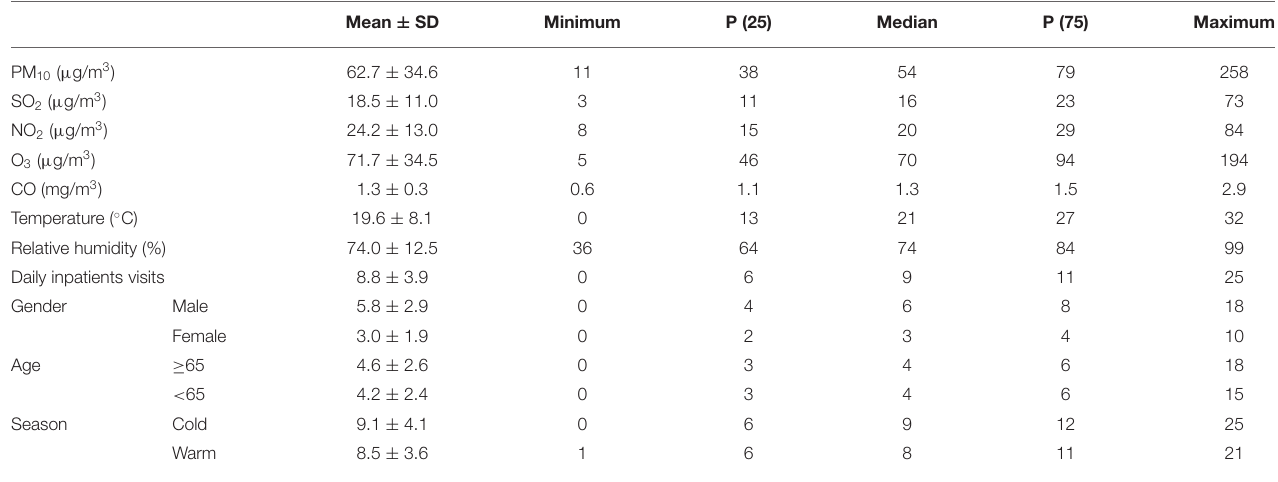
TABLE 1 | Data for ambient air pollutants, weather conditions, and respiratory inpatient visits in Ganzhou from 2017 to